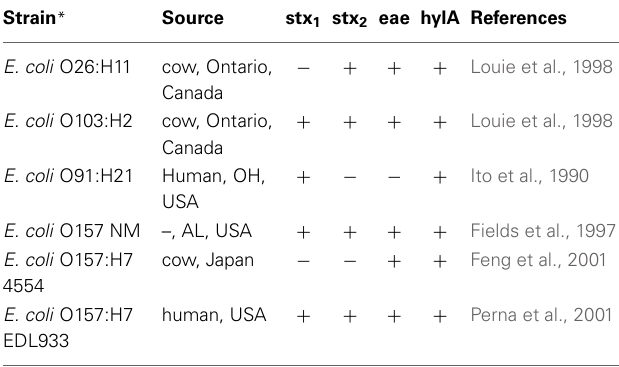
Table 1 | E. coli O157 and non-O157 strains used for the